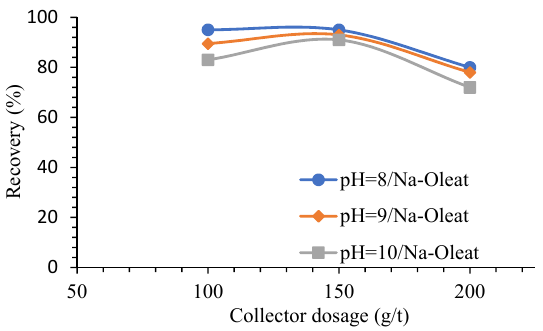
Figure 9. Influence of different Na-Oleat dosages on boron mineral recovery in various pHs (reverse flotation) [40].